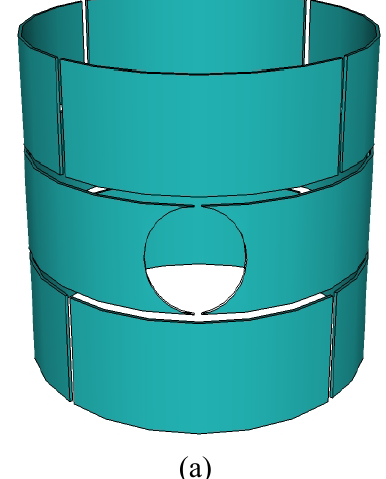
Figure 6. ECVT sensor for the visualization of horizontal gas jet penetration in a gas-solid fluidized bed: (a) configuration of the sensor with a jet tube; (b) photo of the ECVT